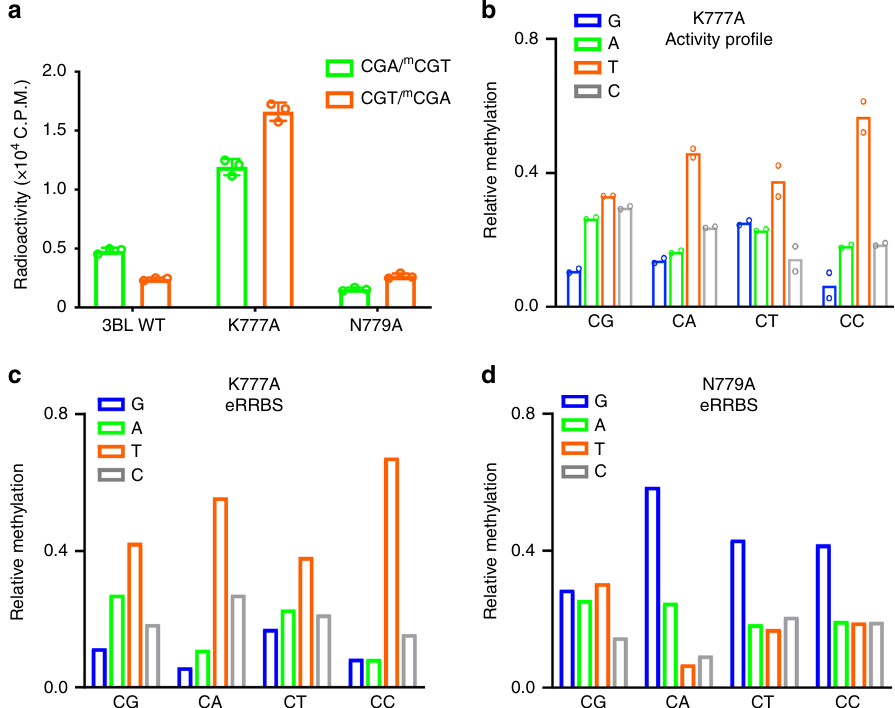
Fig. 7 K777 mediates the + 1 fl anking site preference of DNMT3B. a In vitro methylation analysis of hDNMT3B – hDNMT3L, WT or mutants, on hemimethylated CGT and CGA DNA. The data and error estimate were derived from three independent measurements. b Deep enzymology pro fi les for CpG and non-CpG methylation of hDNMT3B K777A averaged for the different + 1 fl anking base pairs. The data show average methylation levels based on two independent experiments. c , d eRRBS-based methylation analysis of CpG and non-CpG methylation of DNMT3B K777A ( c ) and DNMT3B N779A ( d ) averaged for the different + 1 fl anking base pairs (depth of reads >10). Source data are provided as a Source Data fi